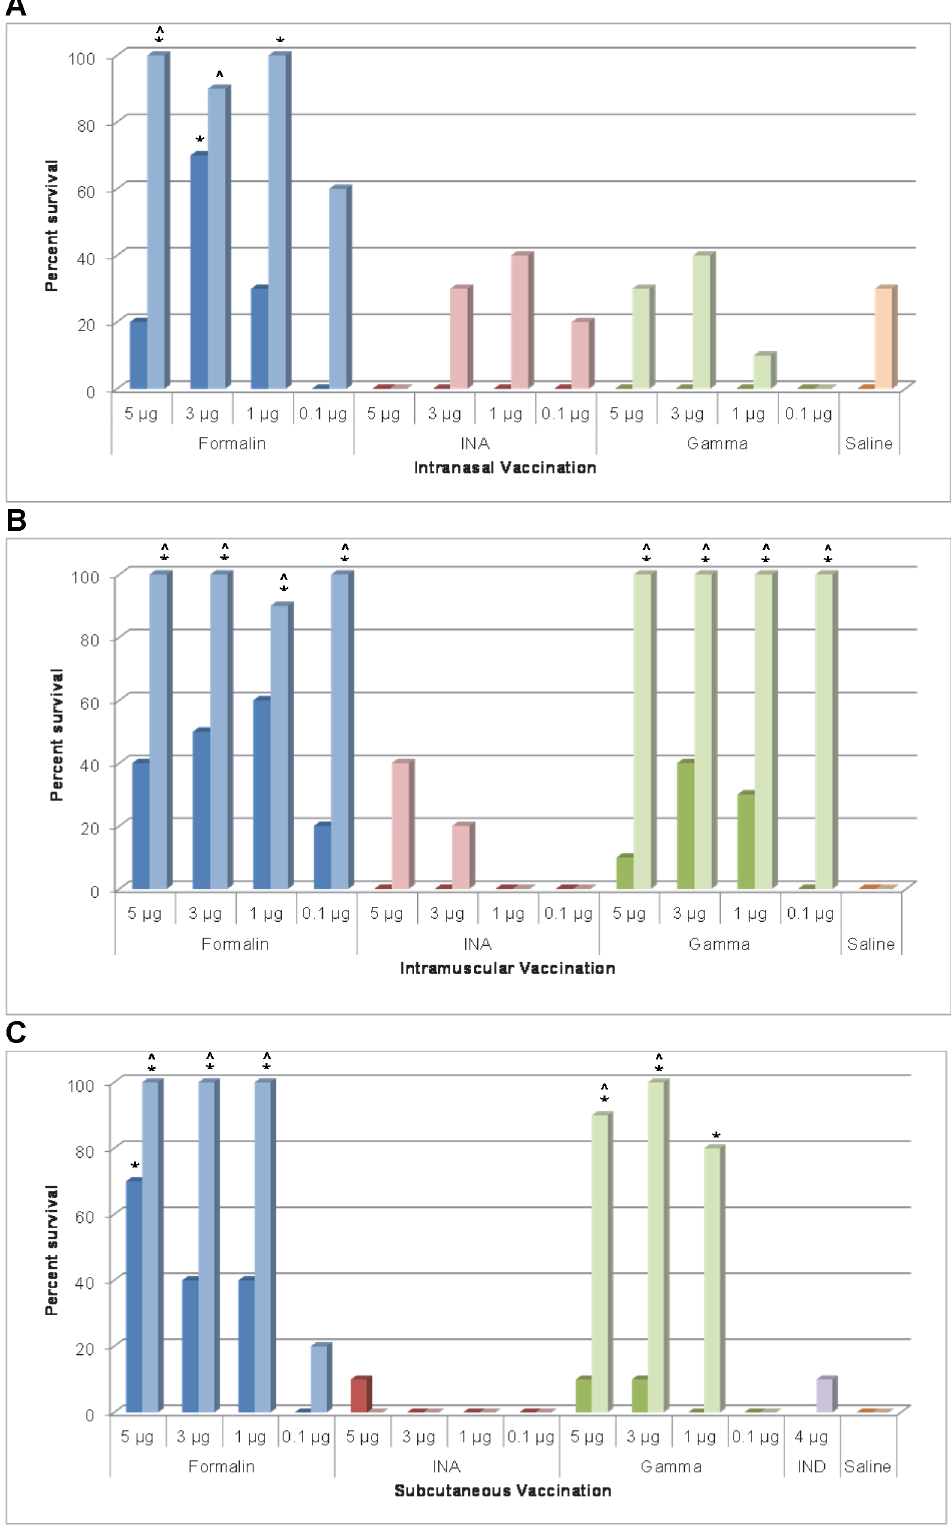
Figure 3. Protective efficacy of iEEEV vaccine candidates. Groups of BALB/c mice (n=10) were administered one (dark bars) or two doses (light bars) of iEEEV vaccine candidate at doses ranging from 5–0.1 m g by IN, IM, or SC routes. Mice were challenged by aerosol with at least 100LD 50 of EEEV strain FL93-939, 28 days after the final vaccination, and were monitored for 28 days for mortality and clinical signs of disease (*p-value , 0.05 for pairwise comparison to saline group; ‘ p-value , 0.05 for pairwise comparison to IND vaccine group).